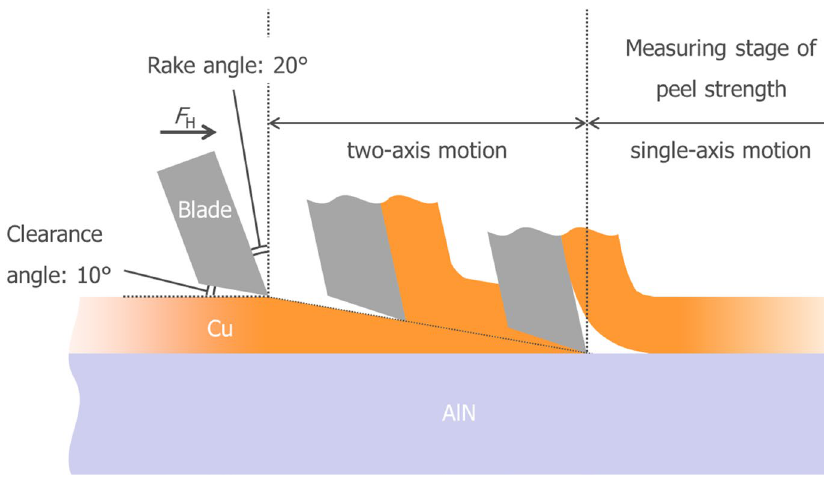
Fig. 2 Schematic diagram of the SAICAS